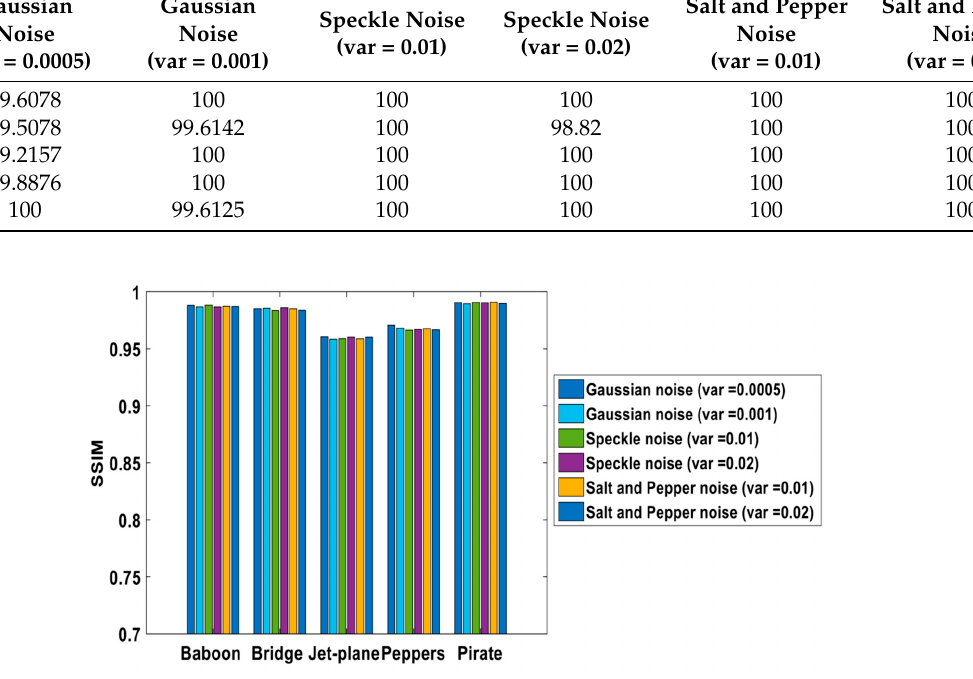
Figure 10. SSIM Value for Different noise